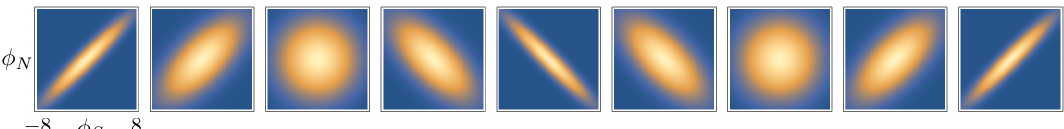
( φ ) = (cid:12) (cid:12) h φ − iH 0 ¯ T | O i (cid:12) (cid:12) 2 for free ω = 0 . 1 scalar on S , φ N S , φ N | e T ) = R dφ ( φ ) is thermal and S N P ¯ T S , φ N